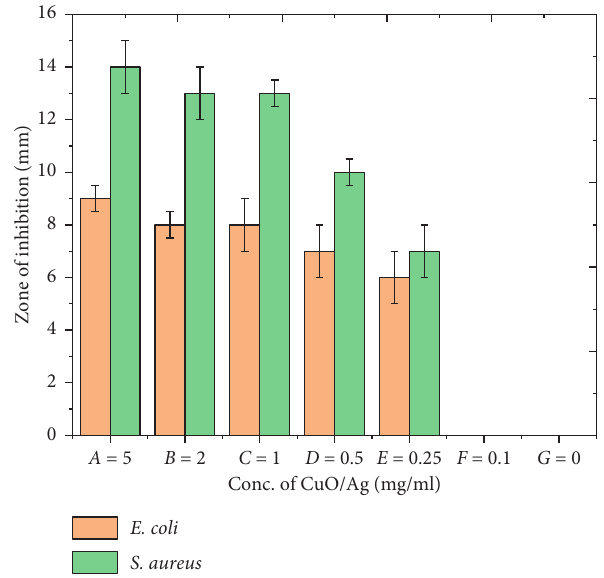
Figure 13: A histogram showing the activity of CuO/Ag nano- composite against E . coli and S . aureus . A � 5mg/ml, B � 2mg/ml, C � 1mg/ml, D � 0.5mg/ml, E � 0.25mg/ml, F � 0.1mg/ml, and G �